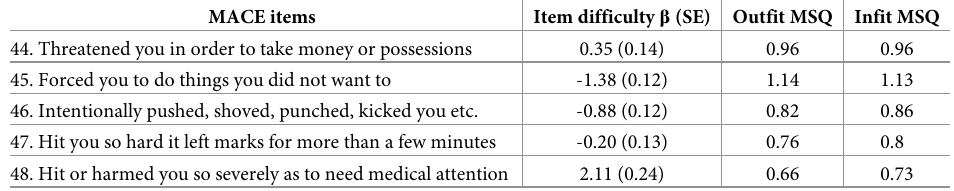
Table 5. Rasch analysis of peer physical bullying subscale. MACE